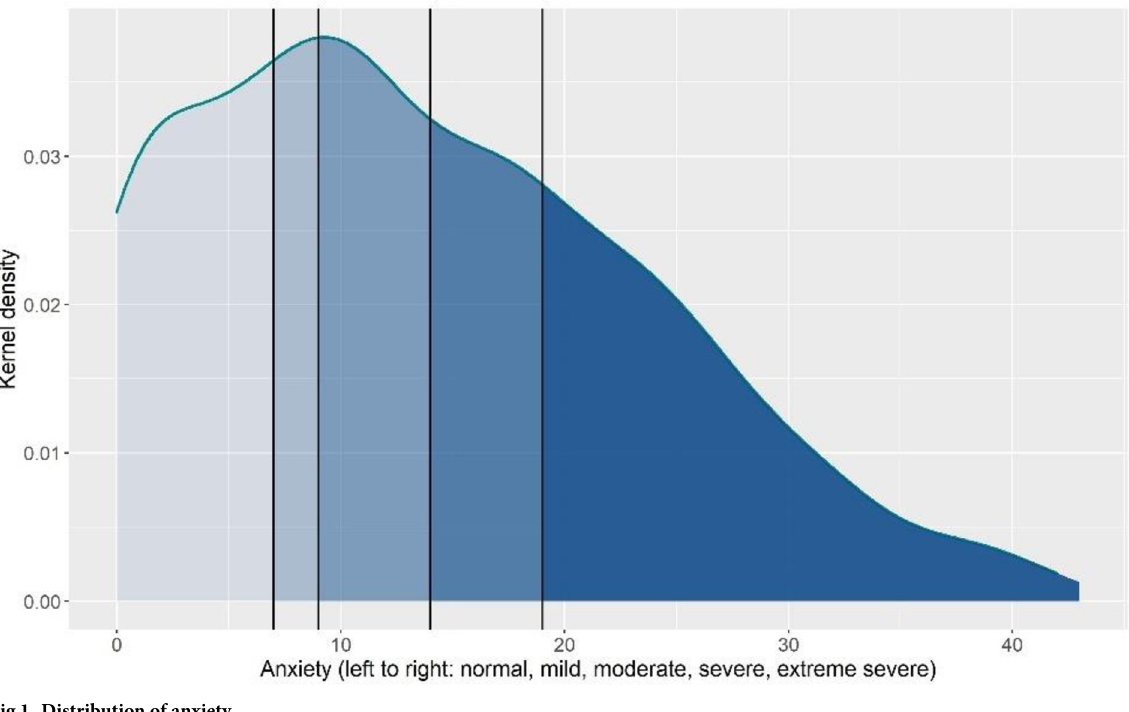
Fig 1. Distribution of anxiety.